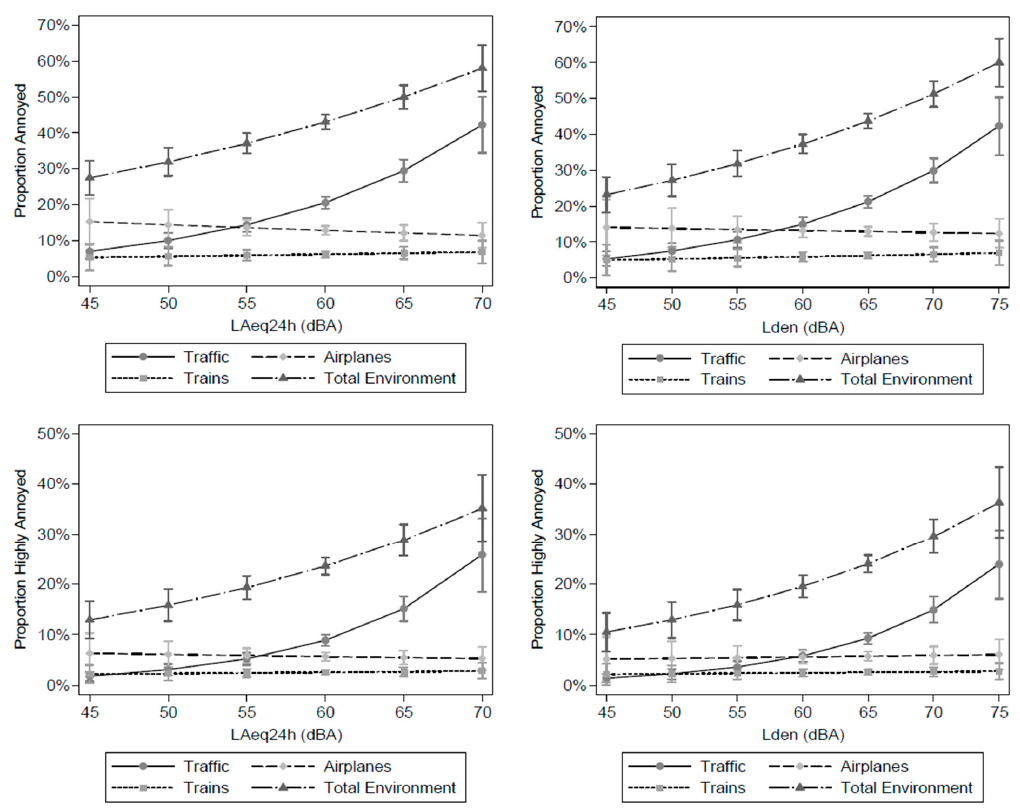
Figure 4. Estimated marginal proportions of annoyed (a lot, quite a bit, somewhat) and (a lot, quite a bit) persons in the total study population (with 95% CI) from traffic, airplanes, trains and total environmental noise (includes noise from transport, neighborhood, industrial and commercial sources, schools, parks, animals and birds) as a function of LA eq24h ( left ) and L den ( right ), adjusted for age, education and